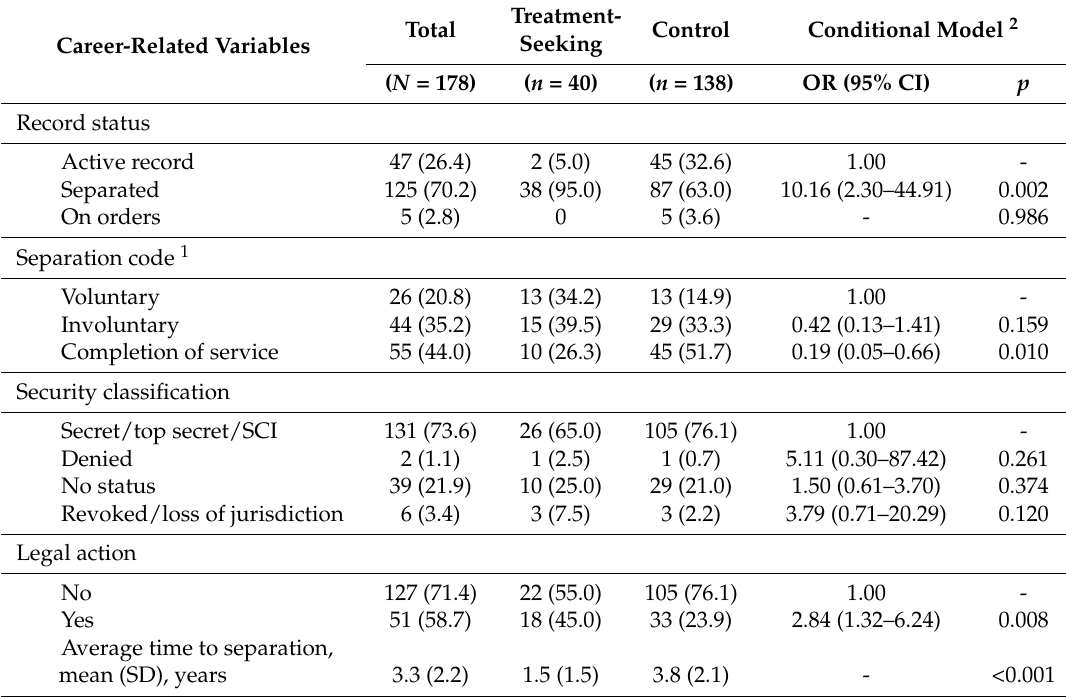
Table 3. Phase 2: Results of conditional logistic regression predicting career-related outcomes